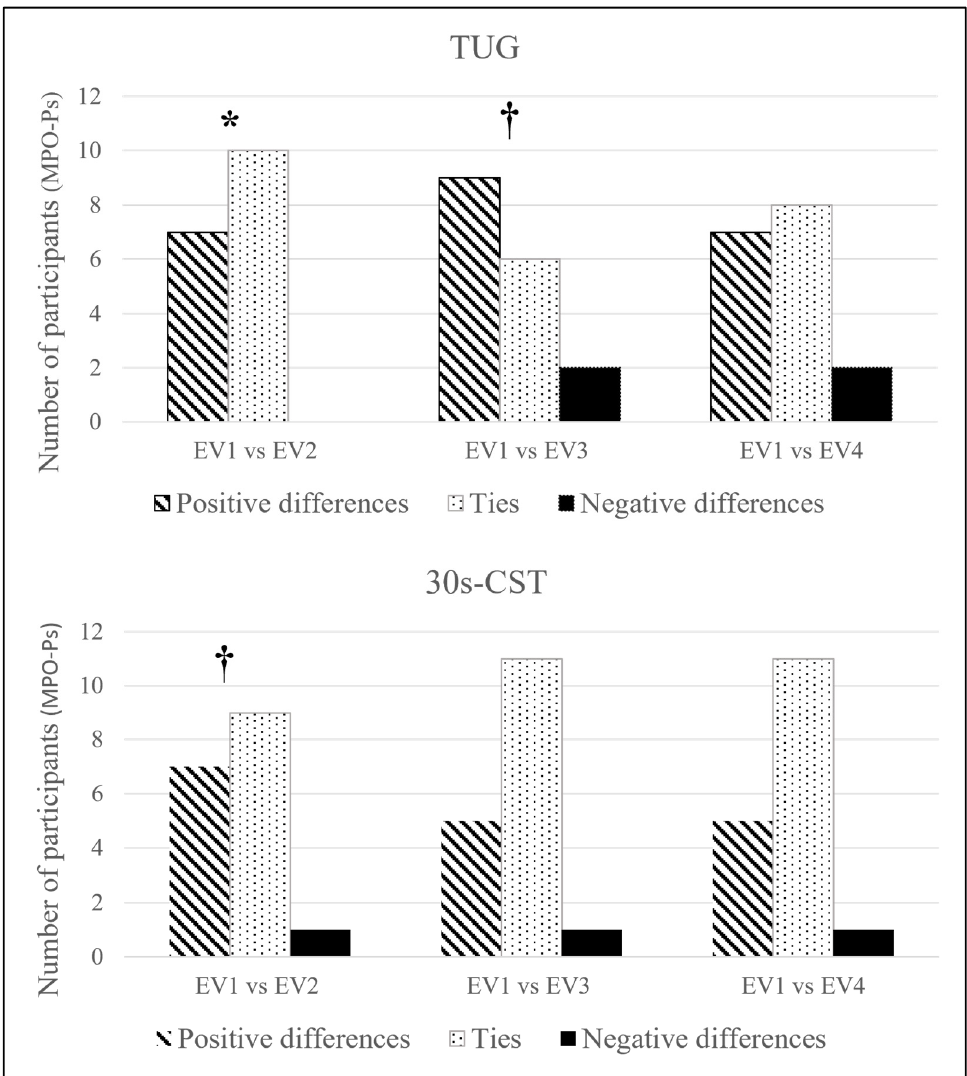
Figure 3. Categorical analysis of the TUG and 30 s-CST. Sign test. Abbreviations: 30 s-CST: Thirty seconds Chair-Stand test; TUG: 8-foot Timed-Up & GO test. * p < 0.05; † p < 0.1.